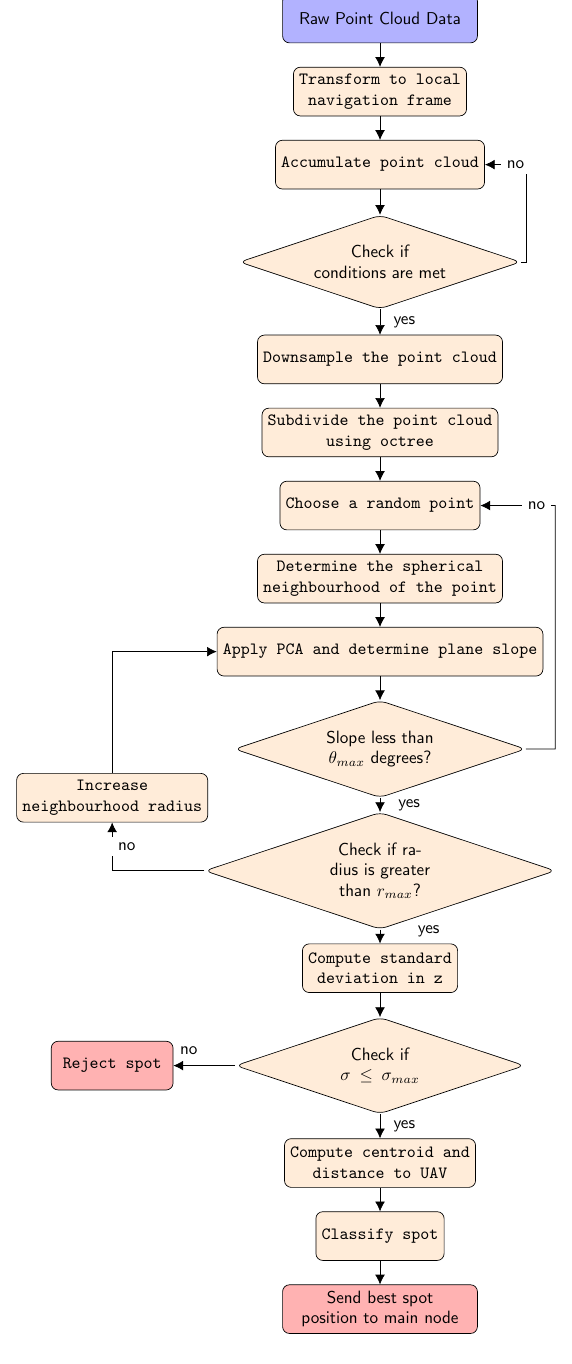
Figure 4. Flowchart of the developed